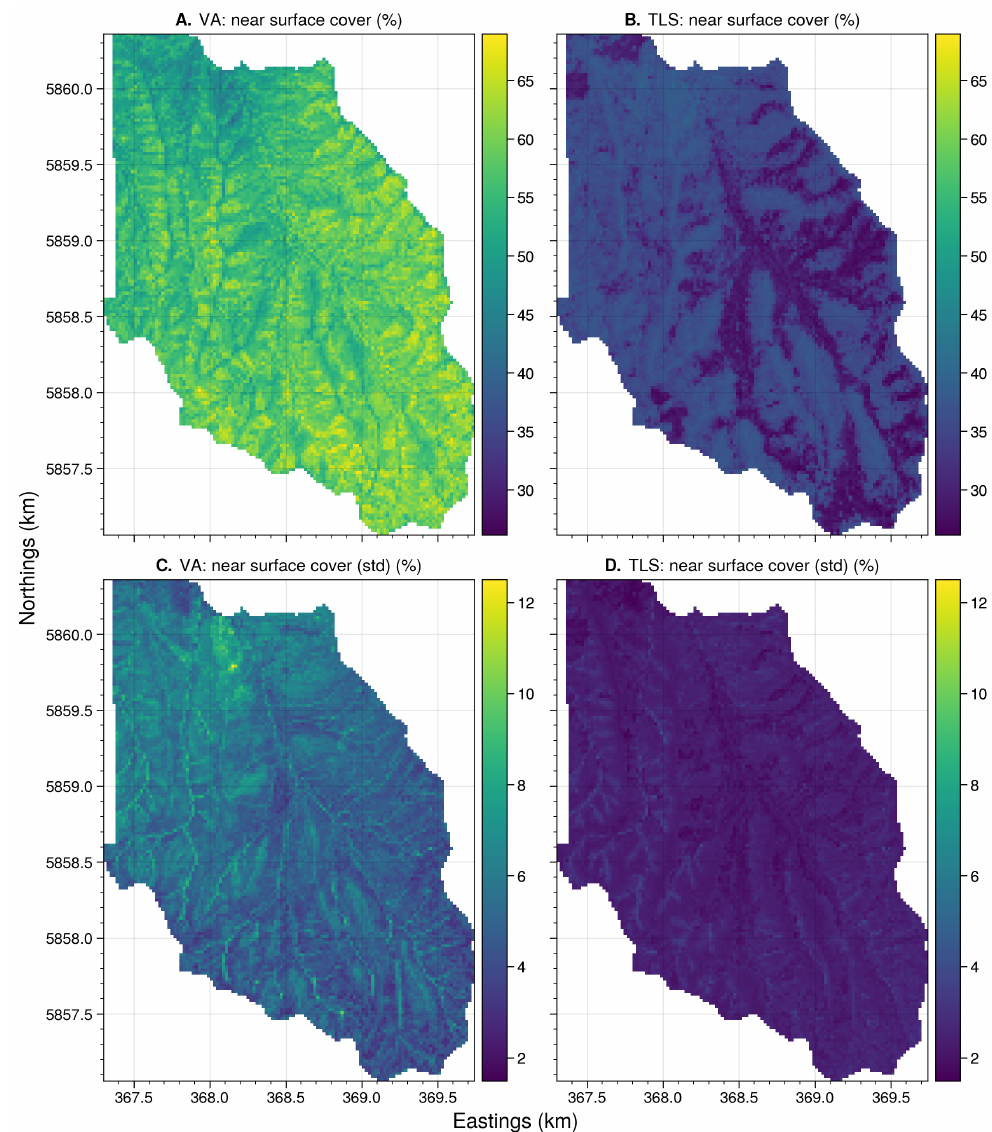
Figure A10. The mean and standard deviation of landscape-level predictions for near-surface fuel cover using visual assessments ( A , C ) and TLS ( B , D ) at